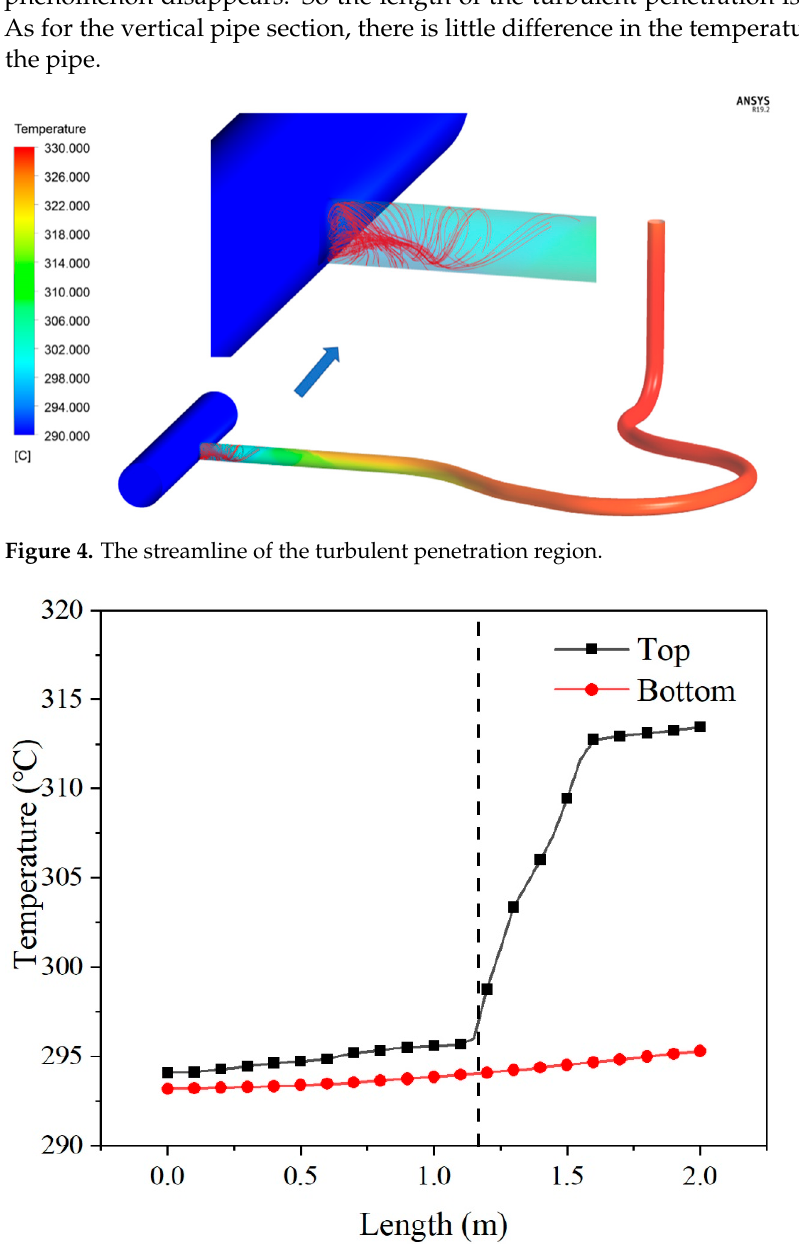
( b ) Figure 3. The finite element model of the surge line and the constraints. ( a ) Ends of the hot leg. ( b ) The pressurizer end. 3.2. Division of Thermal Zones and Working Conditions In order to divide thermal zones, computational fluid dynamics (CFD) simulation